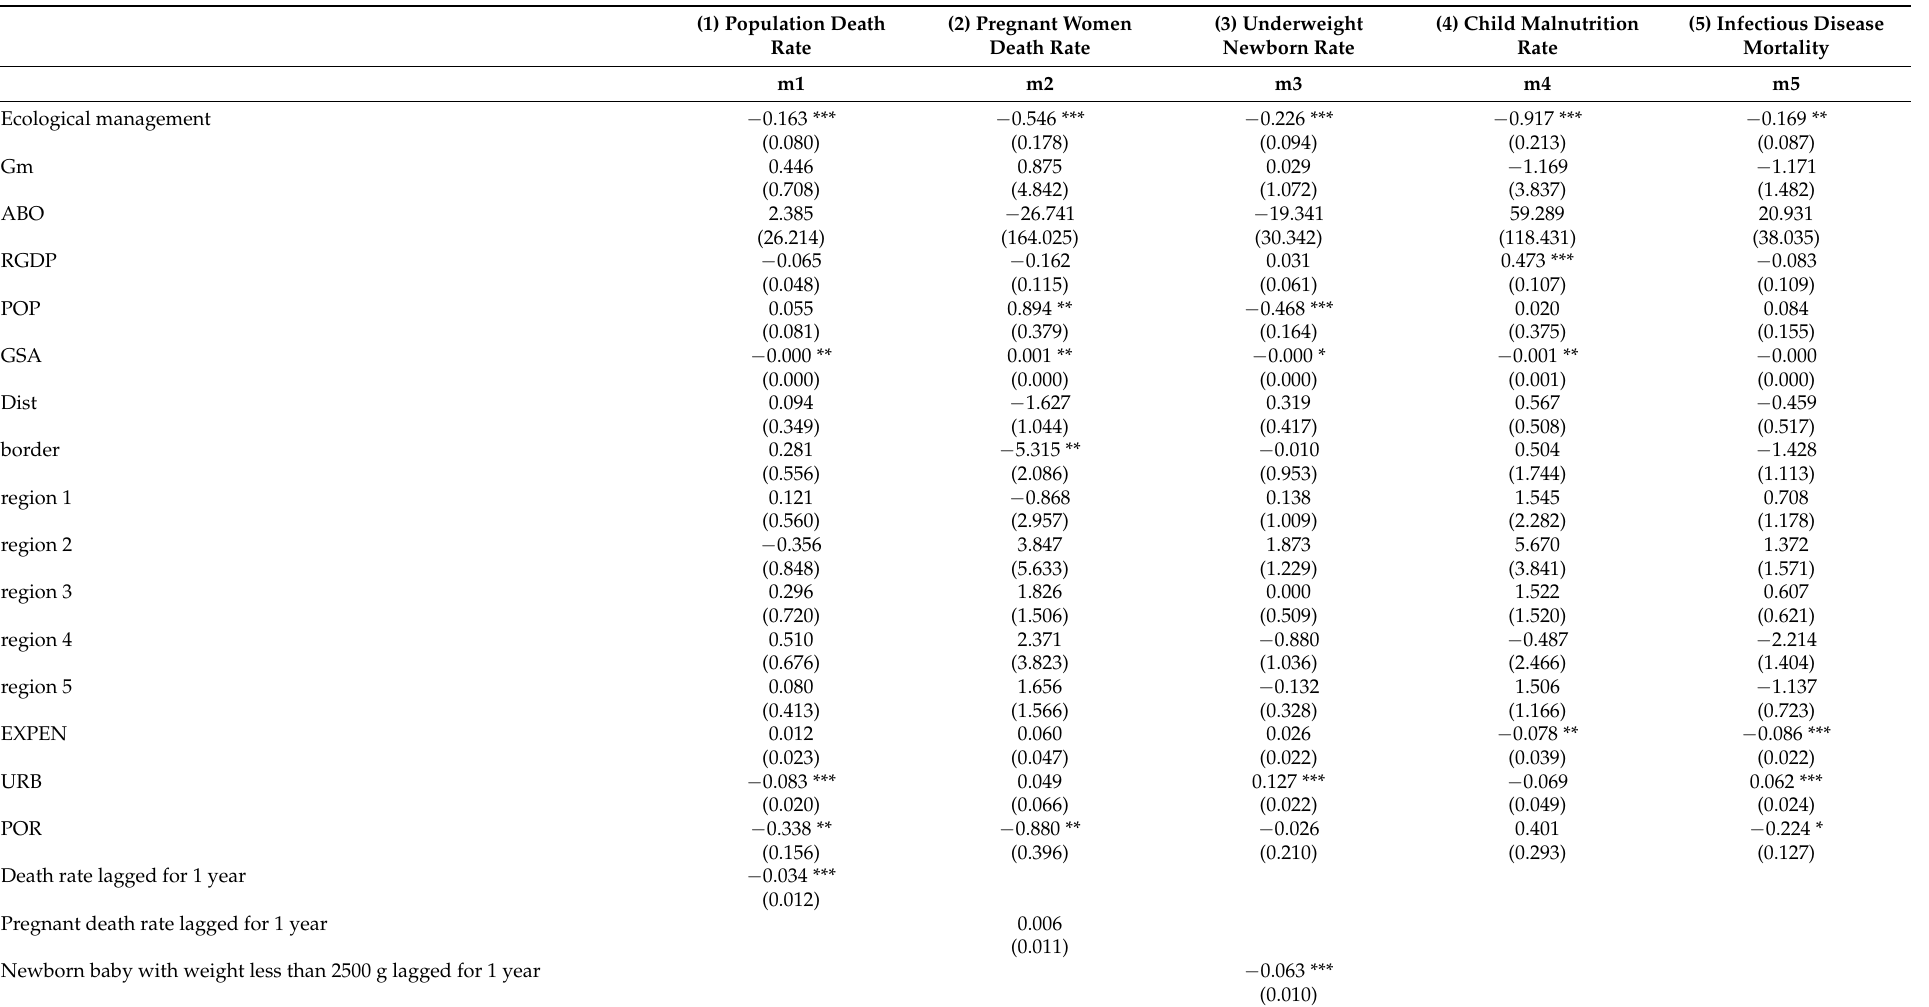
Table 3. Baseline results of sys-GMM